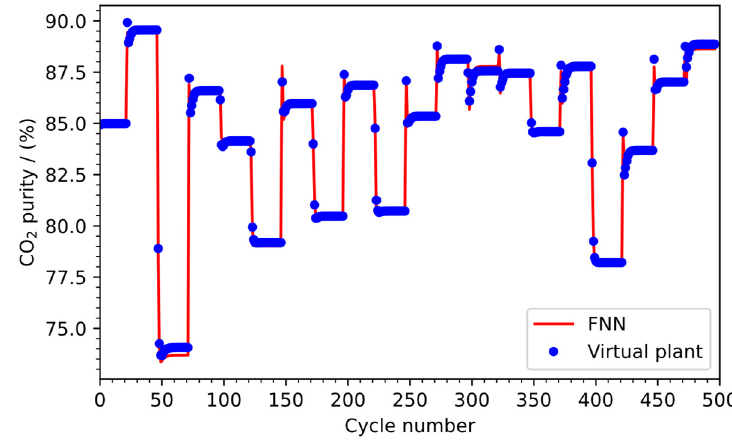
Figure 6. RNN test performance.